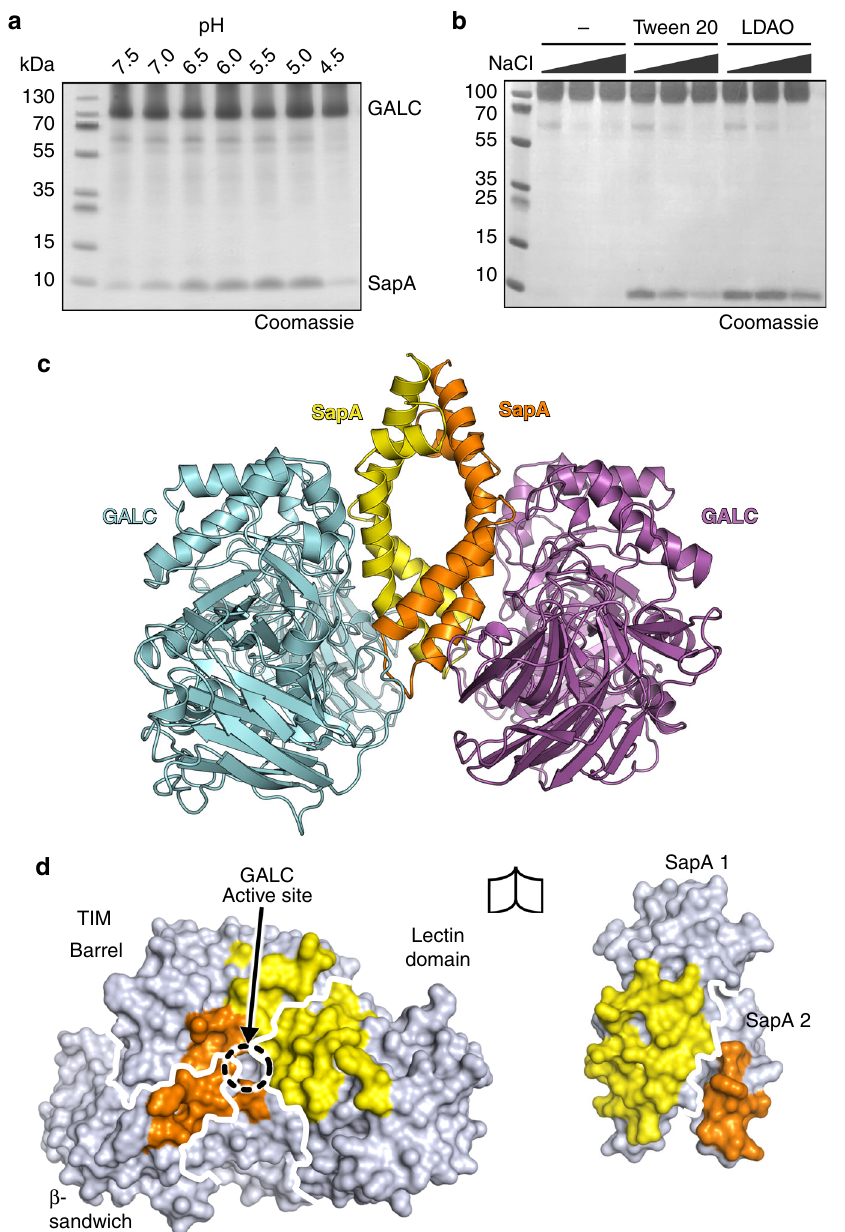
Fig. 2 GALC – SapA complex formation and structure. a Coomassie-stained SDS – PAGE of pulldown assays with immobilised GALC across the pH range 7.5 to pH 4.5 in the presence of detergent. The intensity of SapA binding to GALC is 3.6 times greater at pH 5.5, equivalent to the late-endosomal/lysosomal compartment ( n = 3). Glycosylation of GALC results in a smeared band on gradient SDS-PAGE gels. b Pulldown assays at pH 5.4 identify that the interaction requires the presence of detergents, such as Tween 20 or LDAO, and is reduced with increasing NaCl concentration (20, 150 and 300 mM NaCl). c The crystal structure of the GALC – SapA complex reveals a pseudo-symmetric 2:2 heterotetramer of SapA (yellow and orange) with GALC (cyan and magenta). d The interacting surfaces of GALC (left) and the SapA dimer (right), rotated by 90° with respect to c to highlight the respective interaction surfaces. On the GALC surface the interacting regions contacted by SapA chain 1 (yellow) and SapA chain 2 (orange) are highlighted, the different domains of GALC are outlined (white lines) and the active site is identi fi ed. On the SapA surface the residues that interact with GALC are highlighted for each chain and the different chains of SapA are outlined (white the presence of the detergent LDAO and the X-ray crystal structure of this complex solved and re fi ned to 3.6 Å resolution (Fig. 2c and Table 1). The structure was solved by molecular replacement using the high-resolution structure of GALC ( d min = 1.97 Å, PDB 4CCE 28 ) as a search model. After placement of two GALC molecules, strong F O – F C density was evident and could be readily interpreted as two molecules of SapA (Supplementary Fig. 1a).